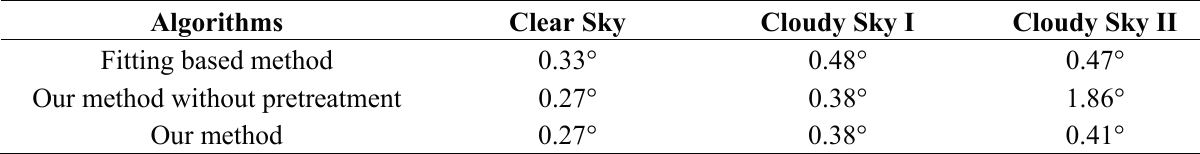
Table 3. The error of the solar meridian orientation extracted by the three methods